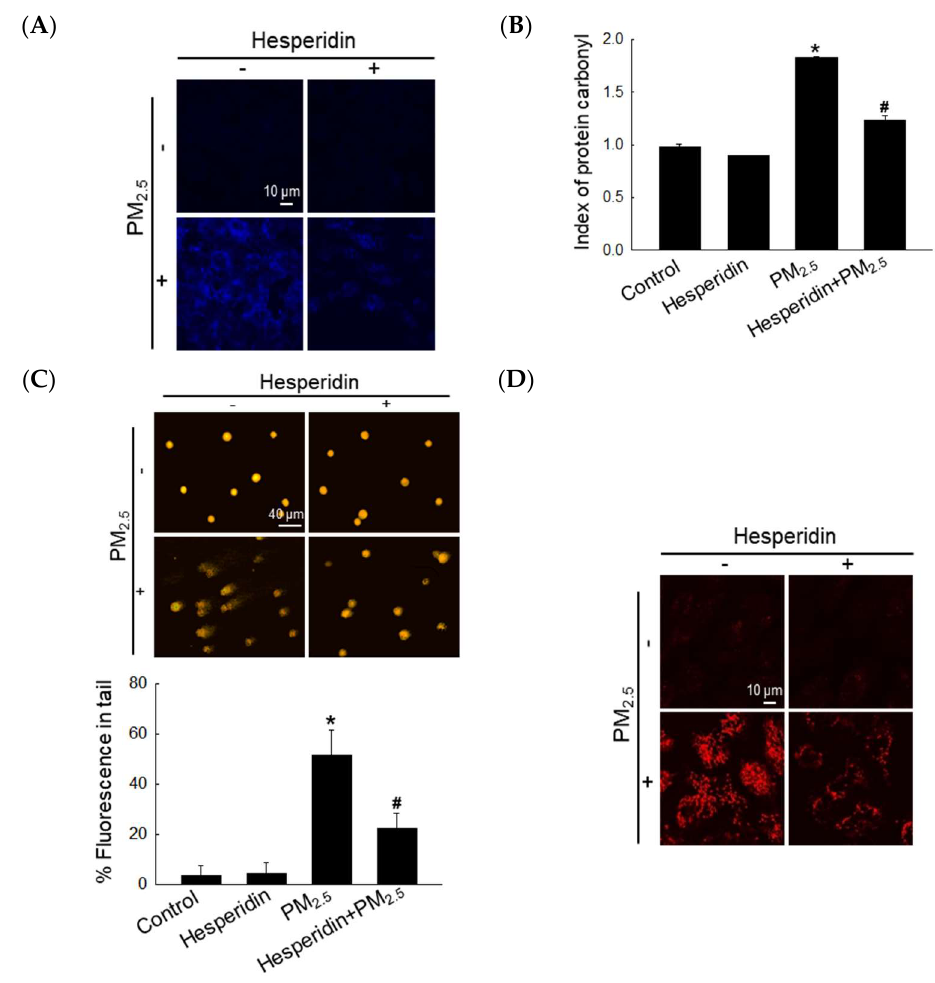
Figure 2. Hesperidin mitigated PM 2.5 -induced lipid peroxidation, protein carbonylation, and DNA damage. Cells were pretreated with hesperidin (50 µ M) for 1 h, and then exposed to PM 2.5 (50 µ g/mL) for another 24 h. ( A ) Lipid peroxidation was detected via the image of DPPP staining. ( B ) Protein carbonylation was detected using the protein carbonyl ELISA kit. ( C ) Comet assay and ( D ) avidin-TRITC staining were used to assess DNA damage. * p < 0.05 and # p < 0.05 compared with the control cells and PM 2.5 -treated cells, respectively.